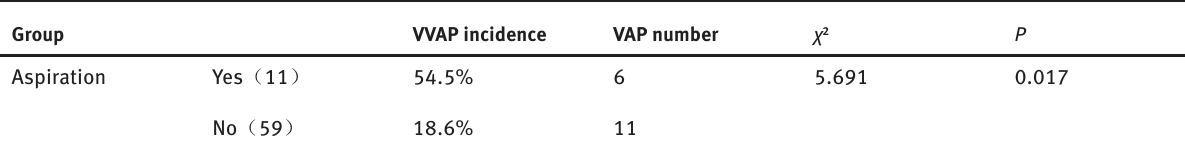
Table 2: Incidence of aspiration and VAP